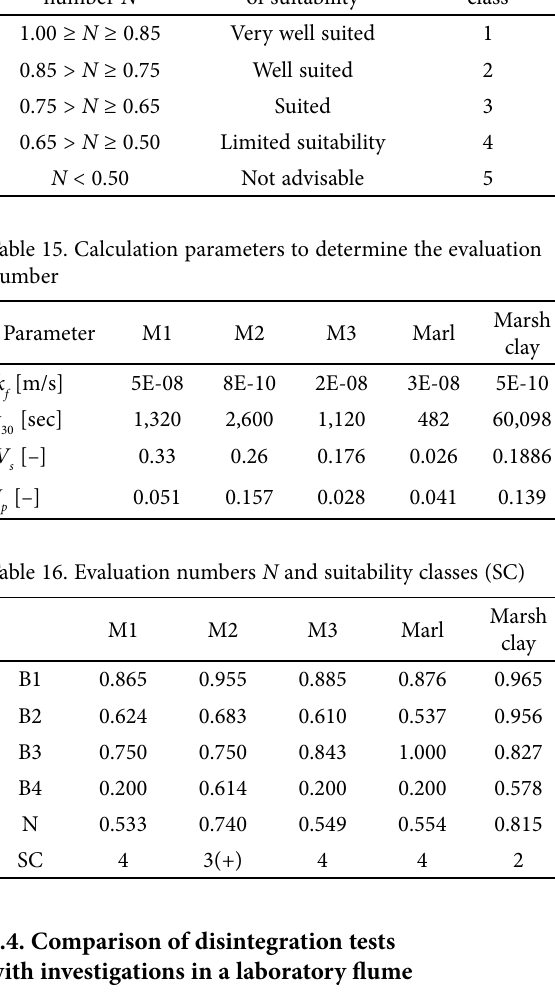
Table 14. Suitability classes with respect to the evaluation